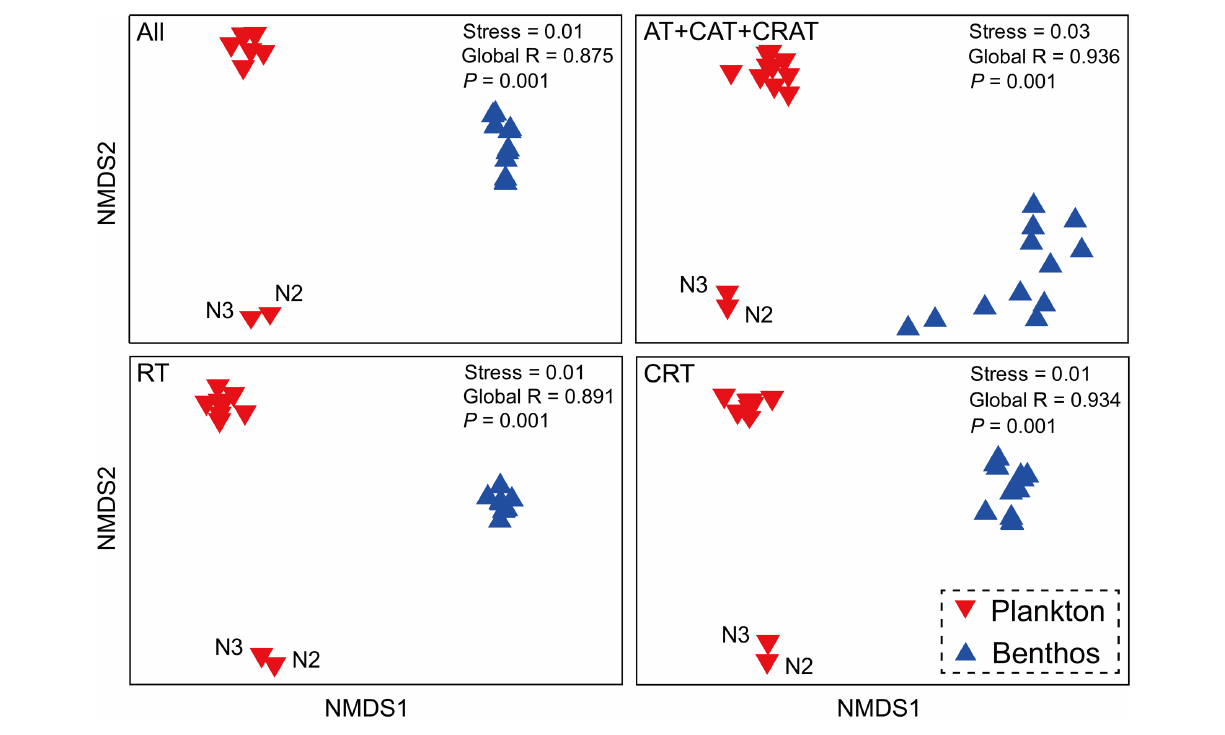
FIGURE 3 | Microeukaryotic community beta-diversity visualized using non-metric multidimensional scaling (NMDS) based on Bray–Curtis similarity. All, all taxa; AT, abundant taxa; CAT, conditionally abundant taxa; CRAT, conditionally rare and abundant taxa; RT, rare taxa; CRT, conditionally rare